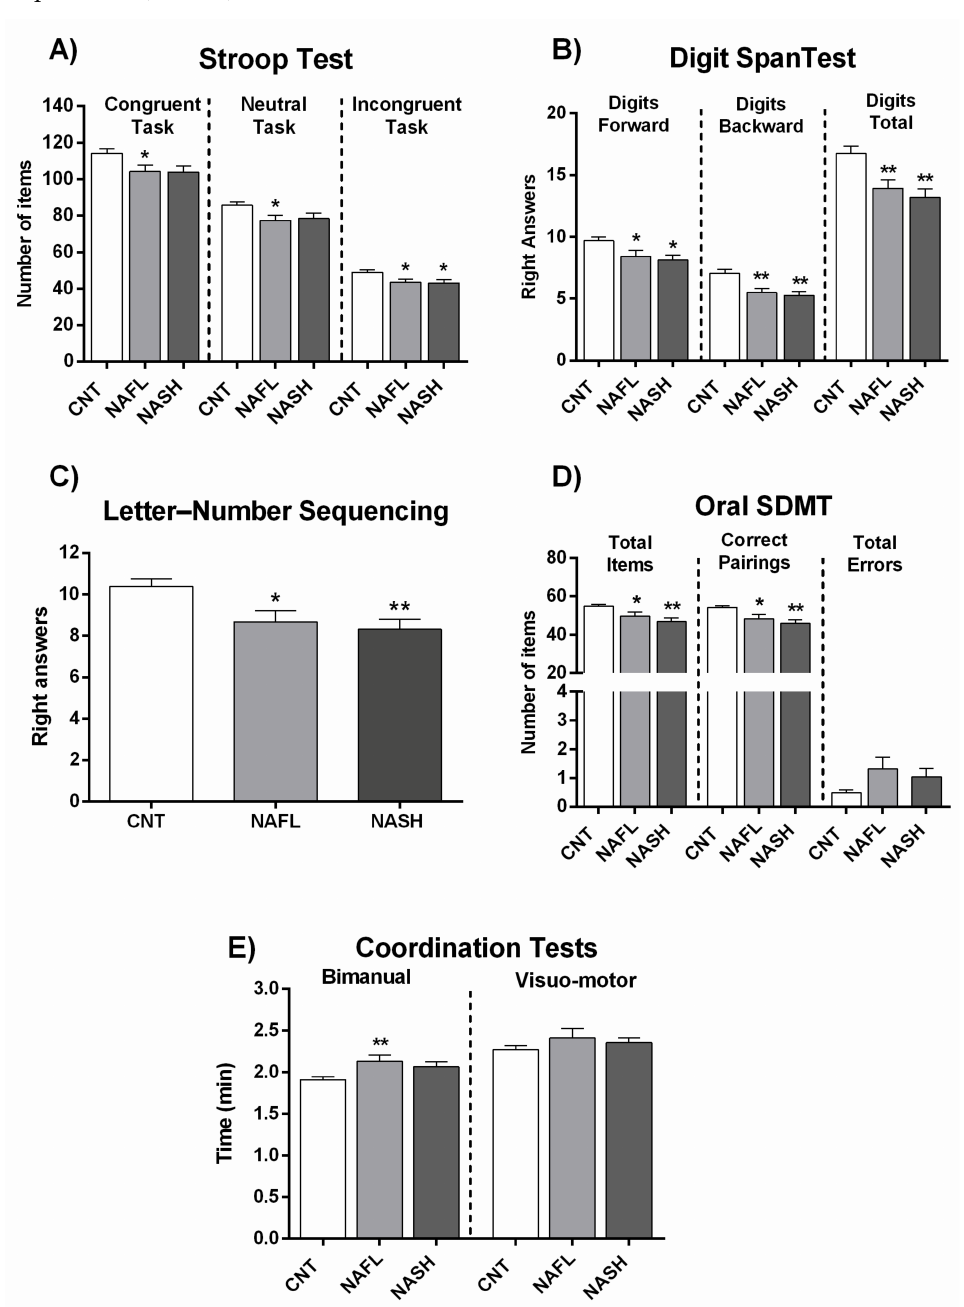
Figure 1. Performance of NAFL and NASH patients in psychometric tests. ( A ) Results of Congruent (number of words), Neutral (number of colors), and Incongruent (number of items completed) tasks in the Stroop test. ( B ) Results of the two tasks of Digit Span test (Digits forward and digits backward), and total Digit score. ( C ) Right answers in Letter-Number Sequencing test. ( D ) Performance in Oral SDMT (Symbol Digit Modalities Test) test. ( E ) Time (min) in Bimanual and Visuo-motor coordination tests. Results are the mean ± SEM (standard error of the mean). * p < 0.05; ** p < 0.01 vs. control group (CNT). NAFL, NASH, patients with nonalcoholic fatty liver and nonalcoholic steatohepatitis,